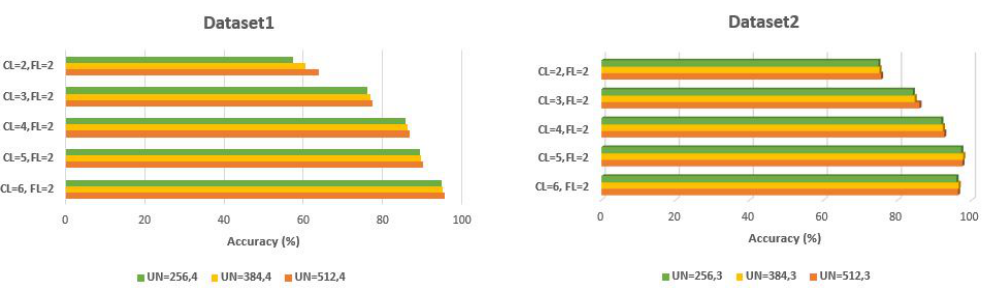
Figure 11. Examples of best performing network structures: dataset1 (top); dataset2 (bottom).